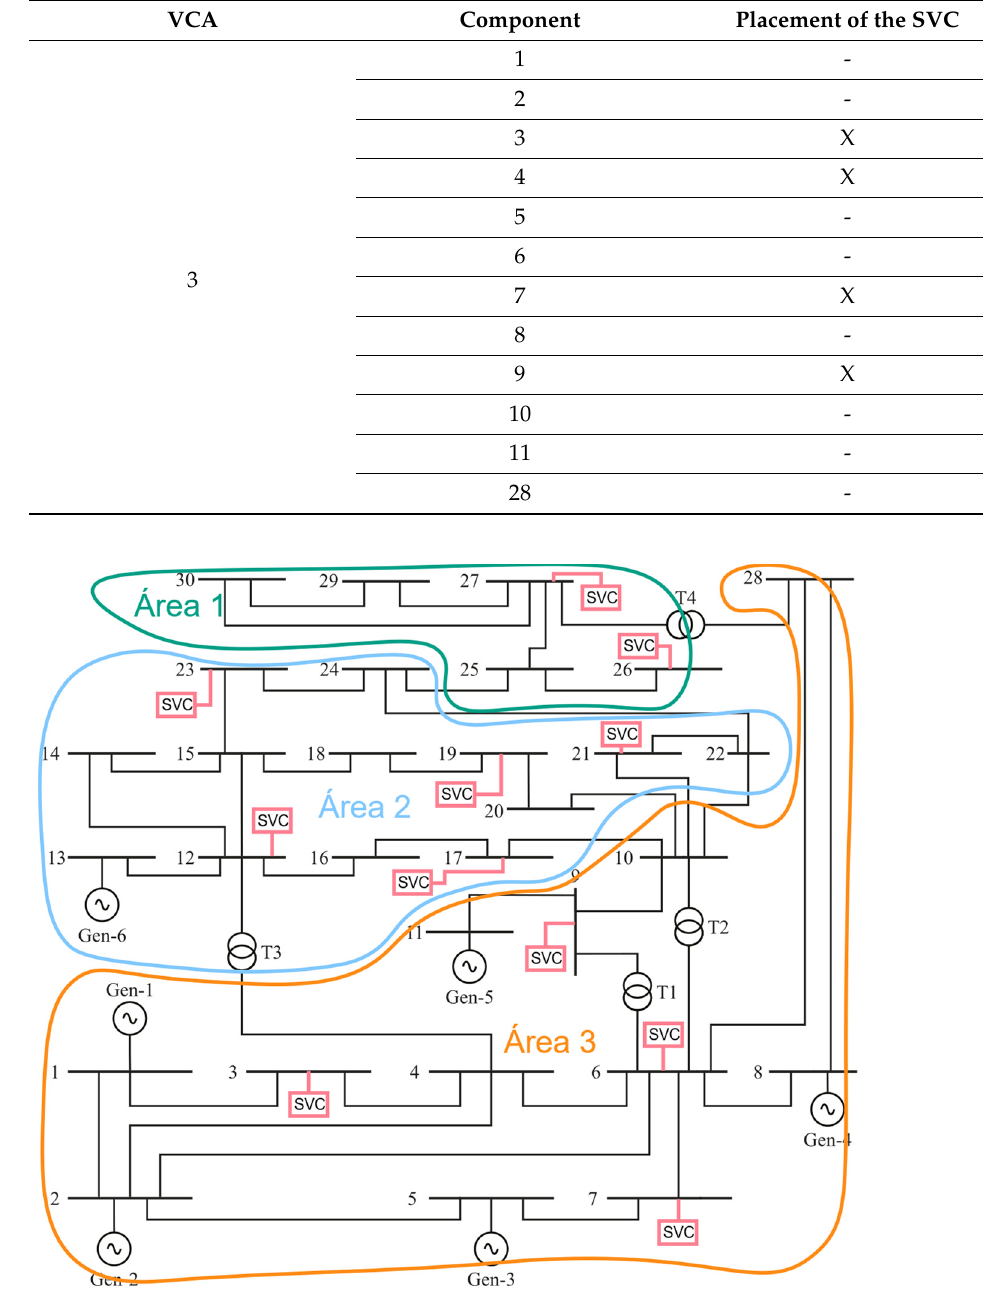
Figure 13. VCAs in the IEEE 30-bus test system. Table 3. Resulting VCAs for the 30-node test scheme. magnitude of 1.06 per unit in some nodes (Figure 14). In contrast, the voltage profile obtained in some nodes is 1 per unit (Figure